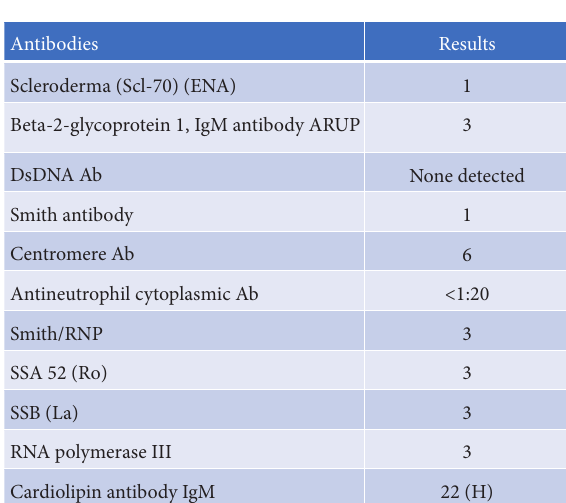
Figure 2: Results of rheumatologic blood